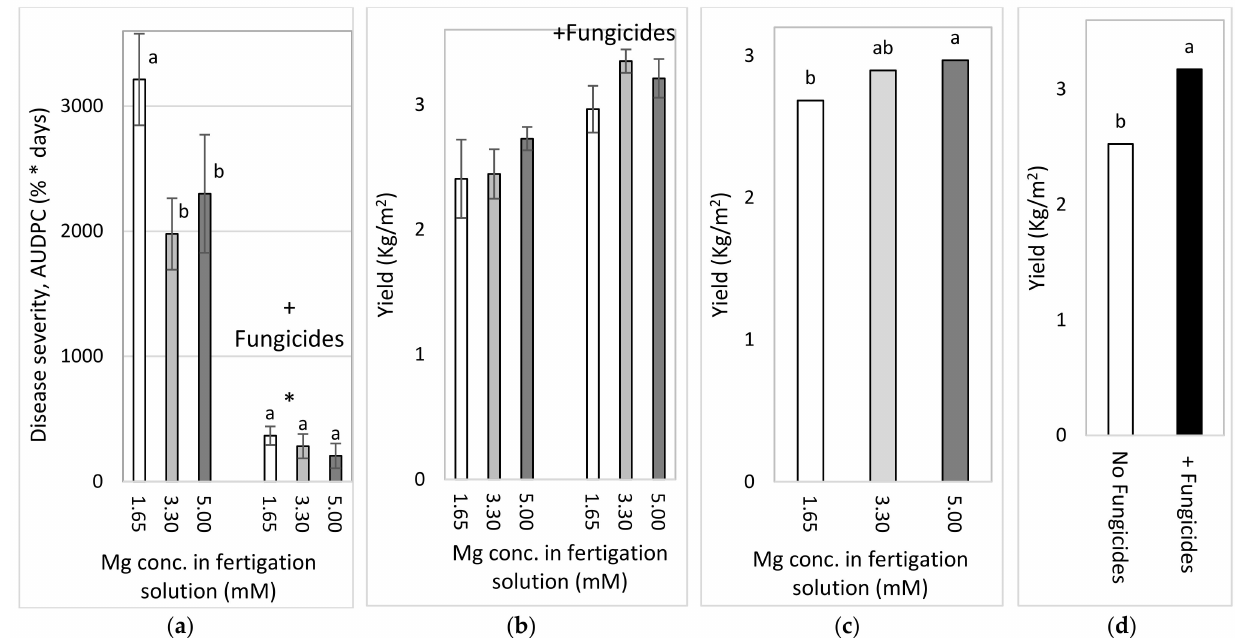
Figure 9. Effects of Mg concentrations on ( a ) the severity of sweet basil downy mildew (SBDM) and ( b – d ) cumulative shoot weight at 98 days after planting. All of the Mg-treatment plots were either not treated or treated with chemical fungicides (+fungicides). SBDM severity was evaluated on a 0–100% scale, in which 0 = healthy plants and 100% = plants completely covered by SBDM symptoms/signs. The area under disease progress curve (AUDPC) over 114 days was calculated. The interaction between the Mg treatments and the fungicide treatment was significant, so an analysis of SBDM severity is presented for individual treatments. Values for three Mg concentrations in both fungicide treatments followed by a different letter are different from each other ( a ). The interactive effect of the Mg treatments and the fungicide treatment on yield was not significant ( b ), so each major parameter was analyzed independently. Mg ( c ) and fungicide treatments ( d ) followed by a different letter are significantly different according to two-way ANOVA with Tukey’s HSD. Default significance levels were set at α = 0.05. * SBDM severity in the fungicide treatments was significantly different from the parallel no-fungicide treatments ( a ). Bar =